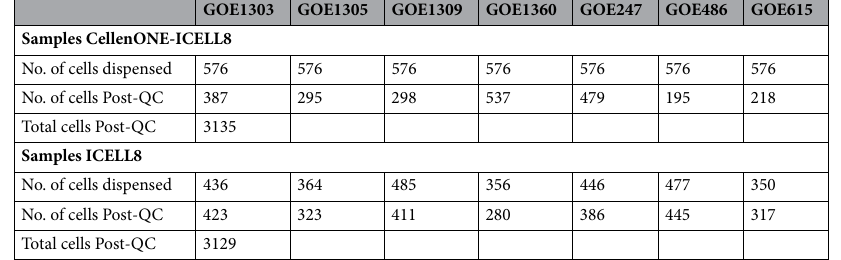
Table 1. Number of cells dispensed and selected for sequencing after QC-filtering data set (CogentDS).